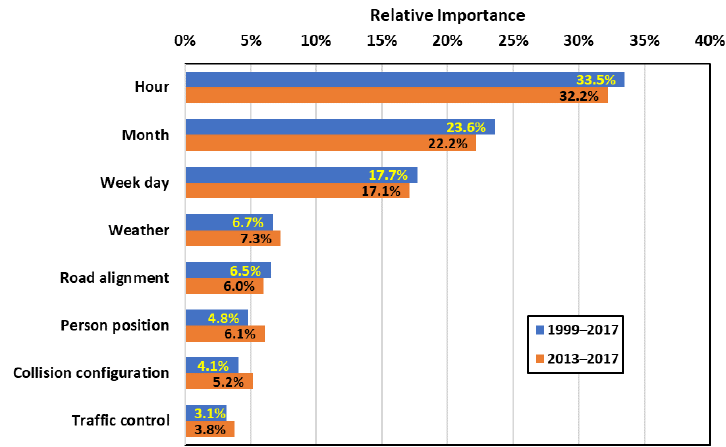
Figure 5. The importance of measurable, predictable or sensible factors influencing the severity of a collision with a parked vehicle among the data set.